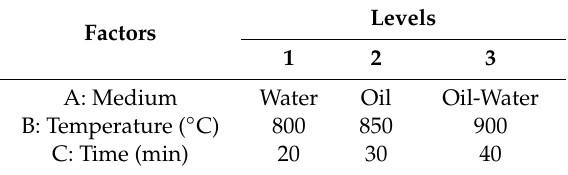
Table 2. Factor and level for DOE (design of experiments) of austenitization.